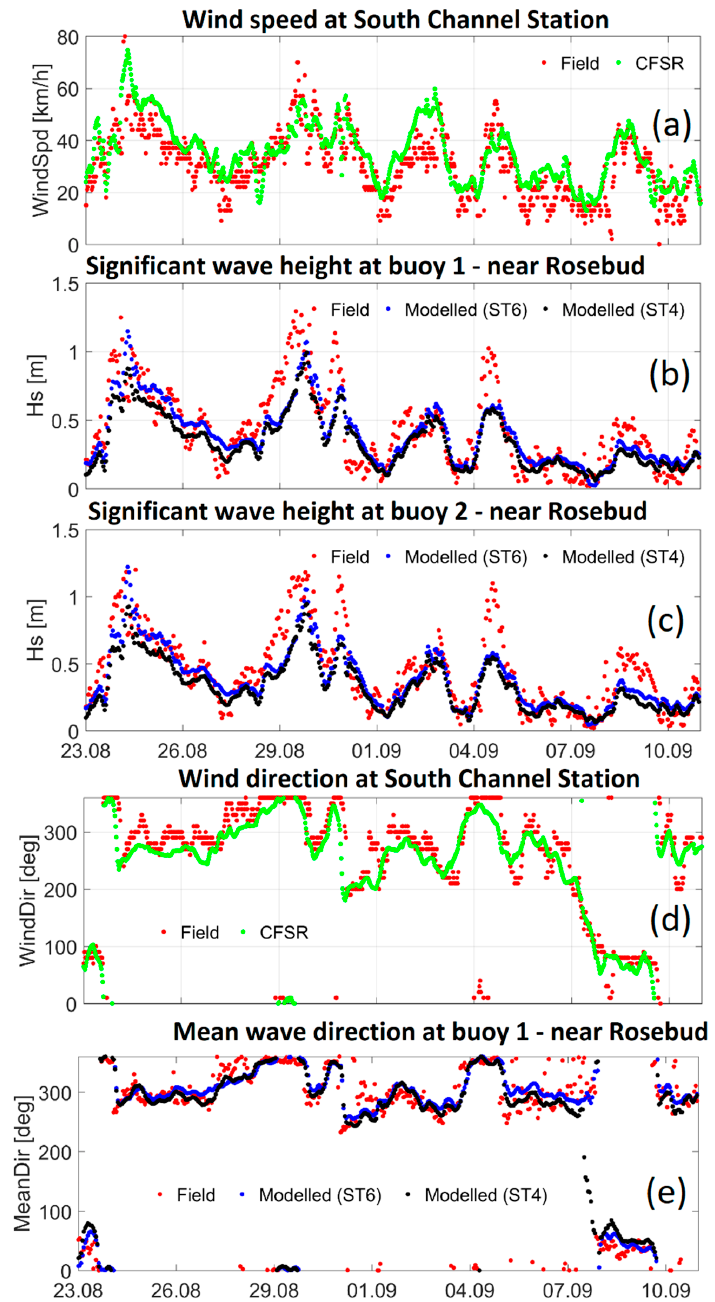
Figure 6. Timeseries plots presenting several parameters obtained in the validation of ST6 physics in the WWM model for PPB: ( a , d )—comparisons between model wind input and measured wind (speed, direction) at the South Channel Station in August 2003; ( b , c )—comparisons between measured and modelled significant wave height at buoys near Rosebud; ( e )—a comparison between modelled (mean) wave direction at one of the two wave buoys and field data. The WWM model performs well with both physical settings (ST4, ST6), but the modelled results with ST6 physics are better specifically in case of a high wind speed. It is noted that when there is a sudden change in the wind direction, both WWMIII with both ST4 and ST6 physics underestimated the